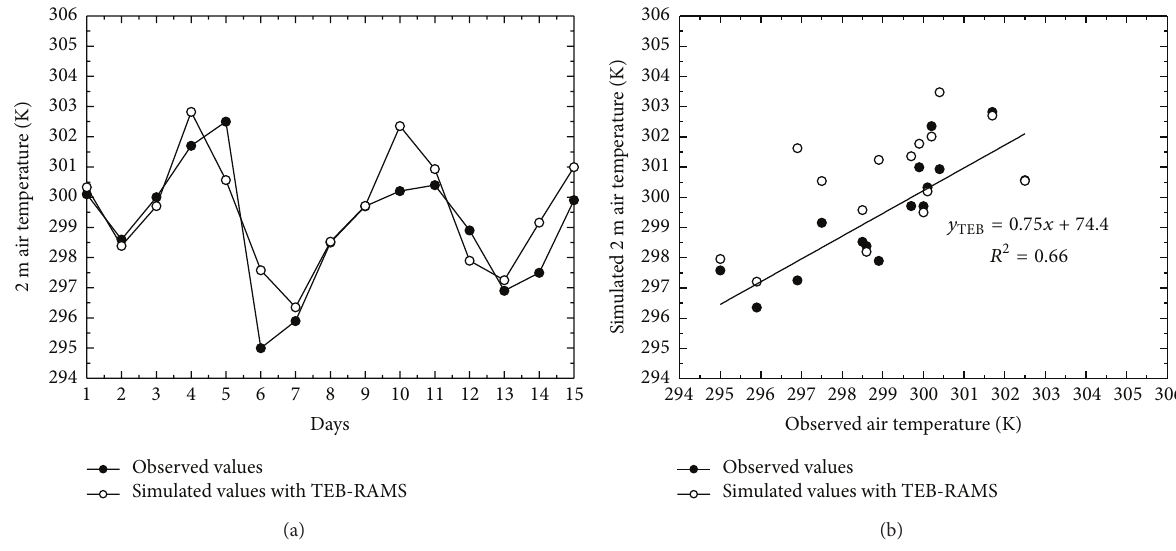
Figure 2: (a) Comparison of the TEB-RAMS model simulated daily 2 m air temperatures with observations from 01 to 15 July 2003, at the Guanxiangtai station. The black filled circle line represents the observed 2 m air temperature in Beijing, and the black open circle line represents the TEB-RAMS simulated 2 m air temperature. (b) The scatter diagram of correlation relationship between the simulated 2 m air temperature and the observed temperature. The black line represents the linear fit trend.